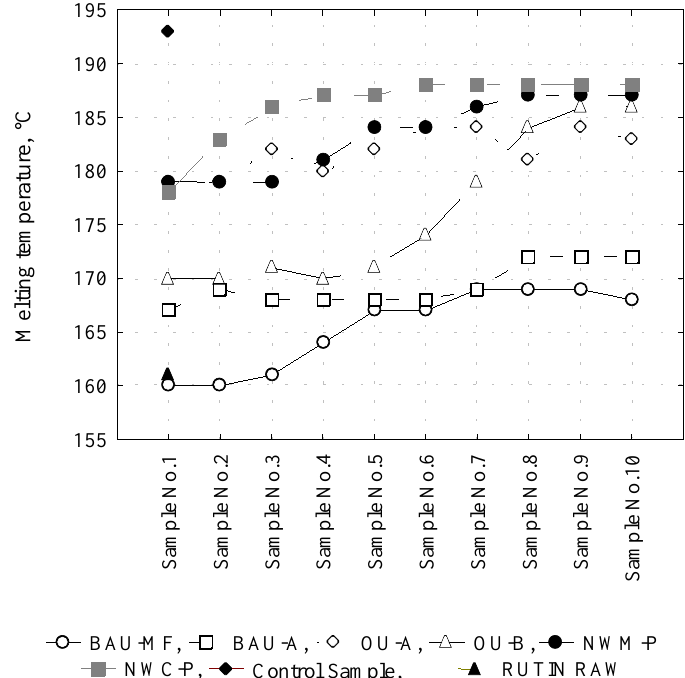
Fig. 1. Dependence of rutin samples melting temperature on carbon brand.